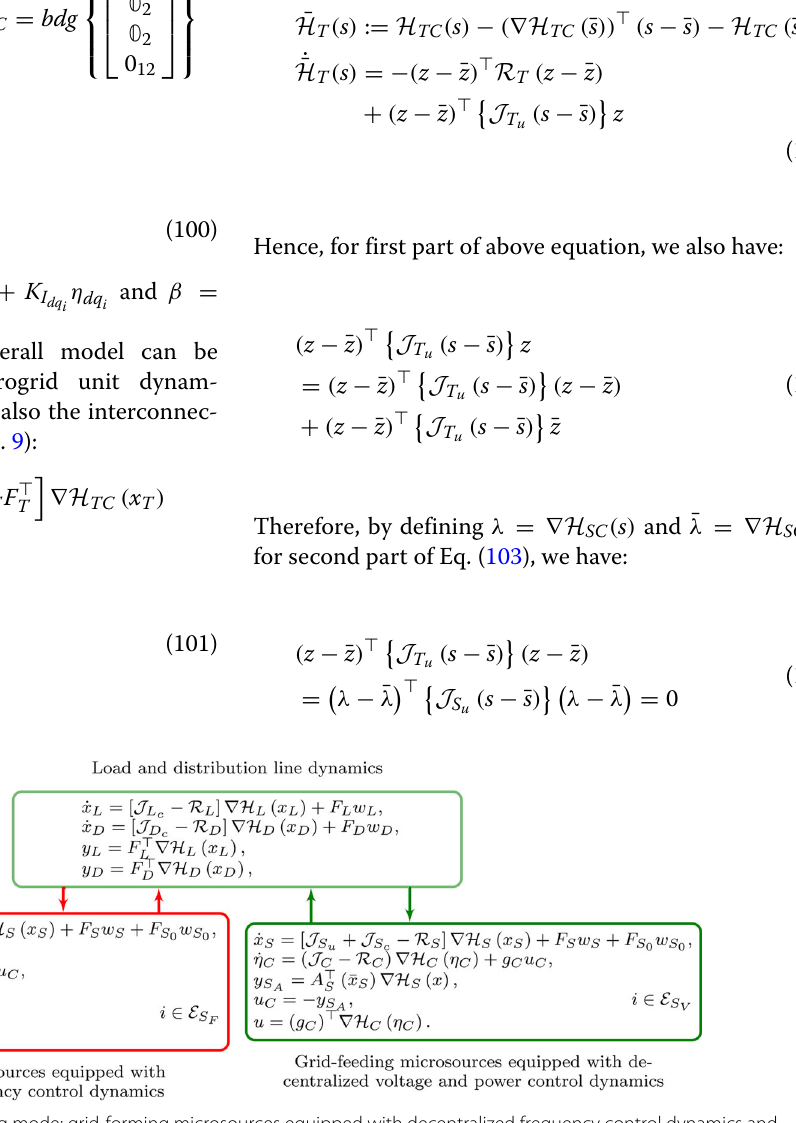
Fig. 9 Overall microgrid dynamic in islanding mode: grid-forming microsources equipped with decentralized frequency control dynamics and grid-feeding microsources equipped with decentralized voltage and power control